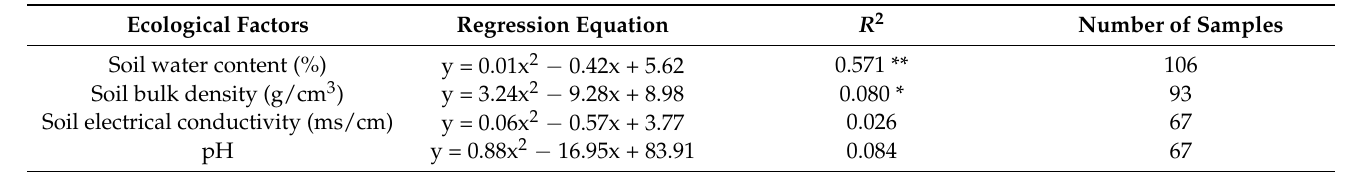
Table 4. Relationship between soil organic carbon (SOC) and ecological factors at 0–100 cm from June to October.